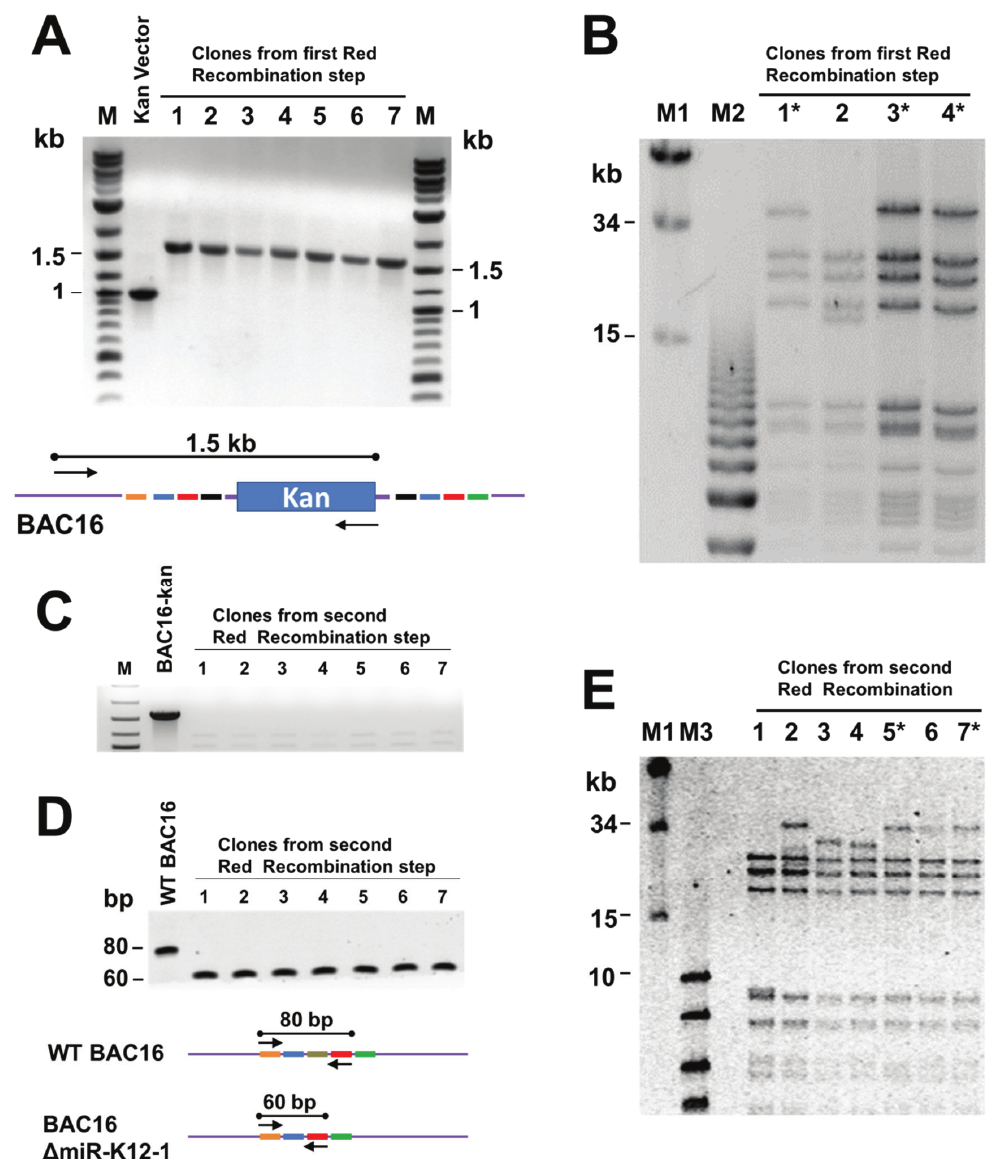
Figure 3. Testing of recombineering products to confirm desired deletion and integrity of